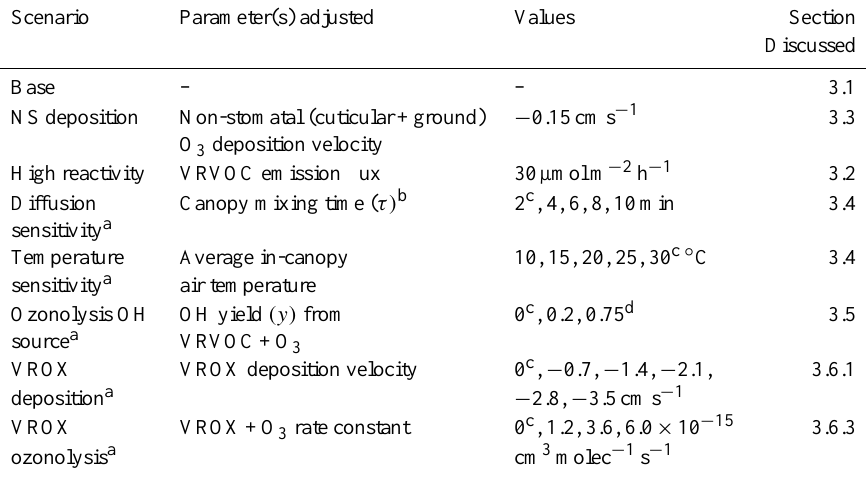
Table 2. Summary of sensitivity simulations. Specific details for individual model runs can be found in the appropriate sections of the text.